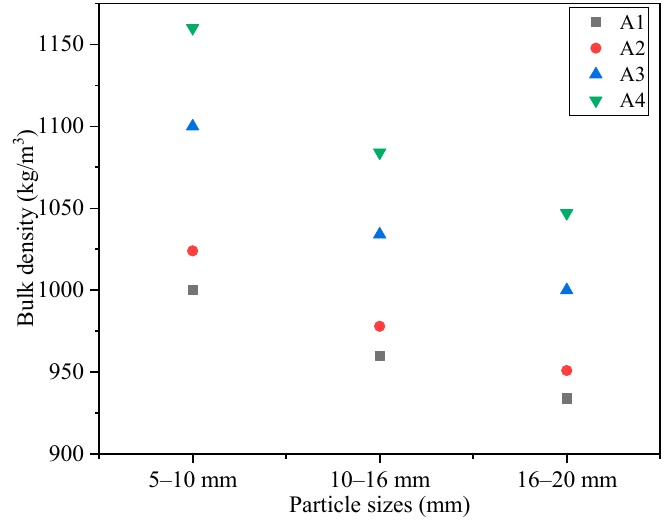
Figure 7. The bulk density of SFLAs with different particle sizes (kg·m − 3 ). Table 7. The apparent density of SFLAs with different particle sizes (kg·m − 3 ).